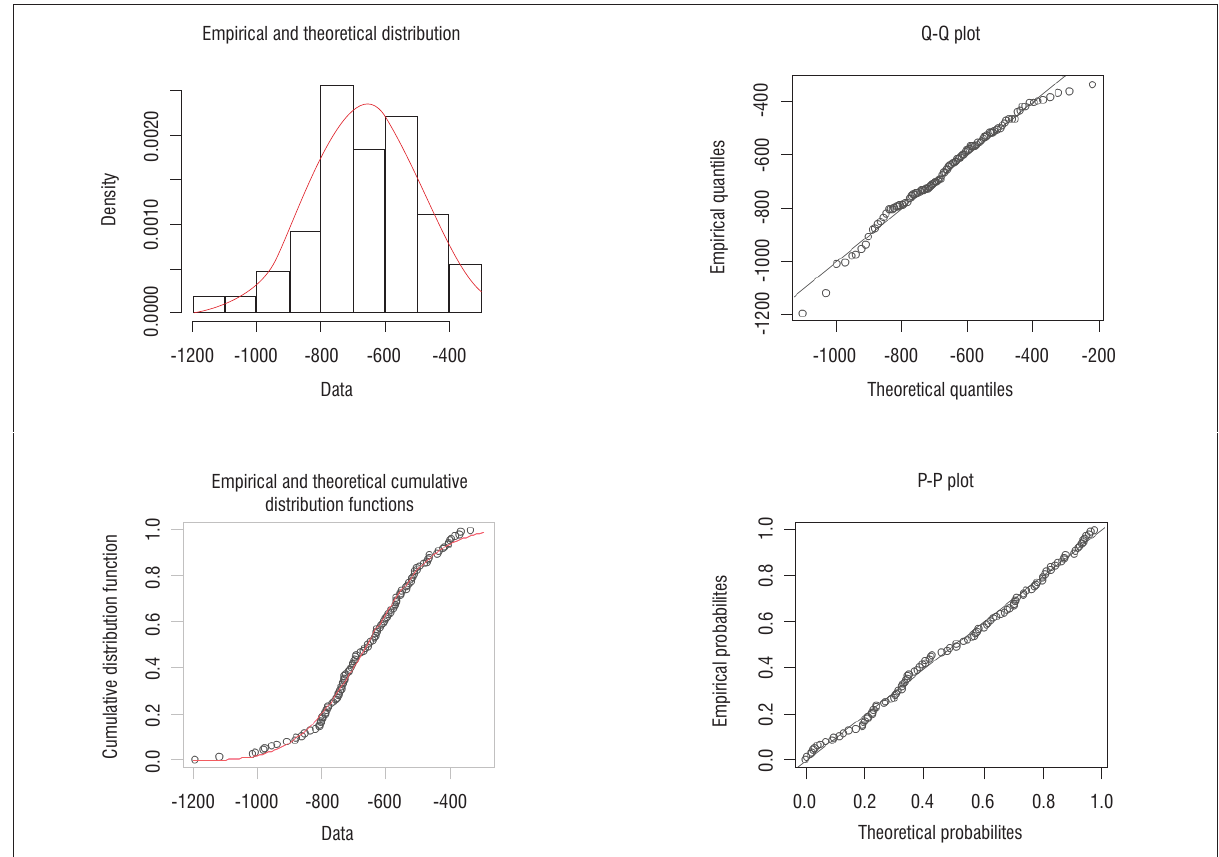
Figure 3: The normal probability density function of minimum annual rainfall for Zimbabwe for the period